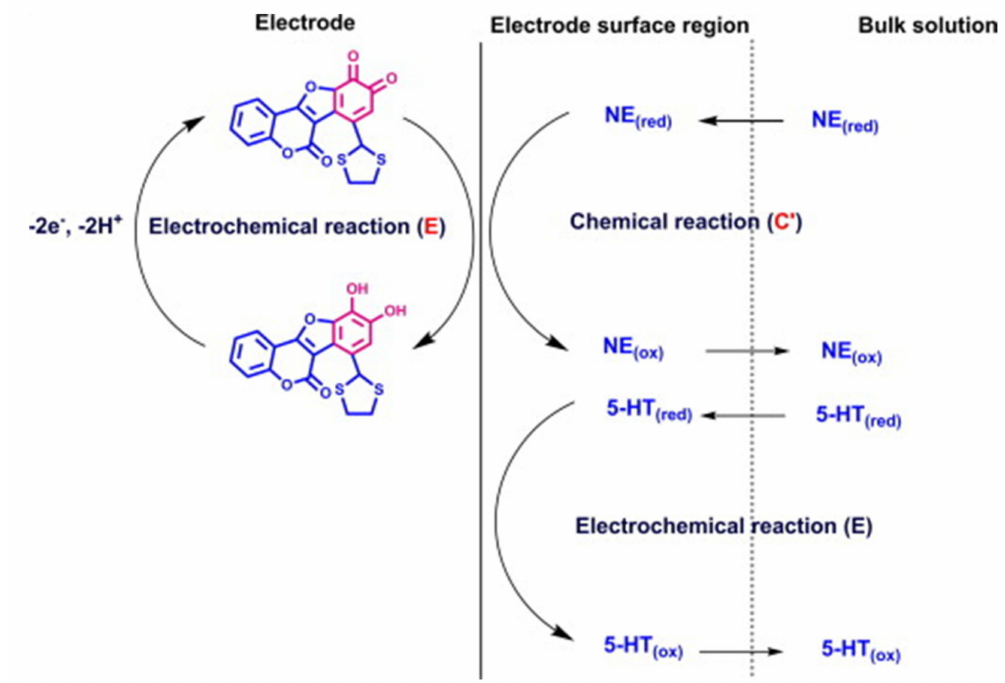
Figure 3. Detection mechanism of the sensor based on a glassy carbon electrode modified with multi-walled carbon nanotubes functionalized with benzofuran derivatives and ionic liquid. Reprinted from [102] with permission of